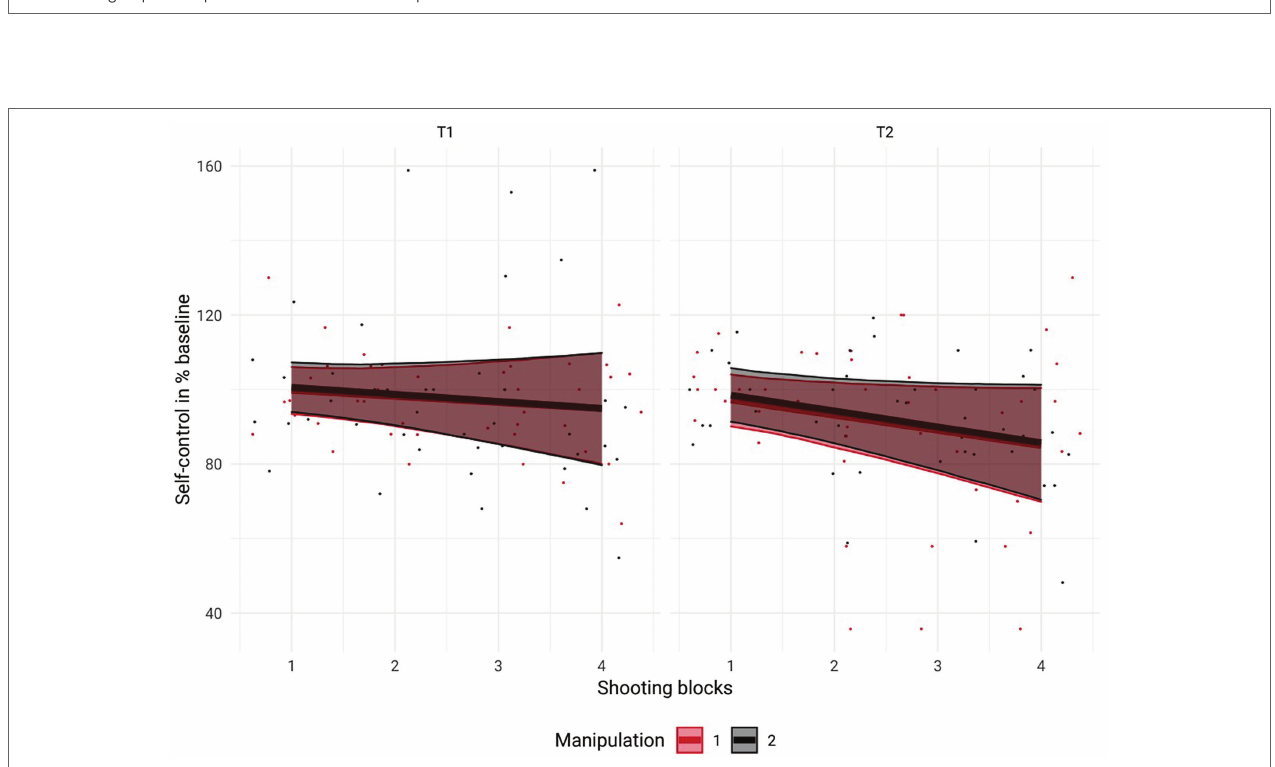
FIGURE 2 | Visualization of shooting performance before (T1) and after (T2) the experimental manipulation as a function of experimental condition. Shooting performance did not change between T1 and T2 and was not affected by prior mental exertion. Data from the experimental group are depicted in red, and data from the control group are depicted in black. Error bars represent 95% credible intervals.